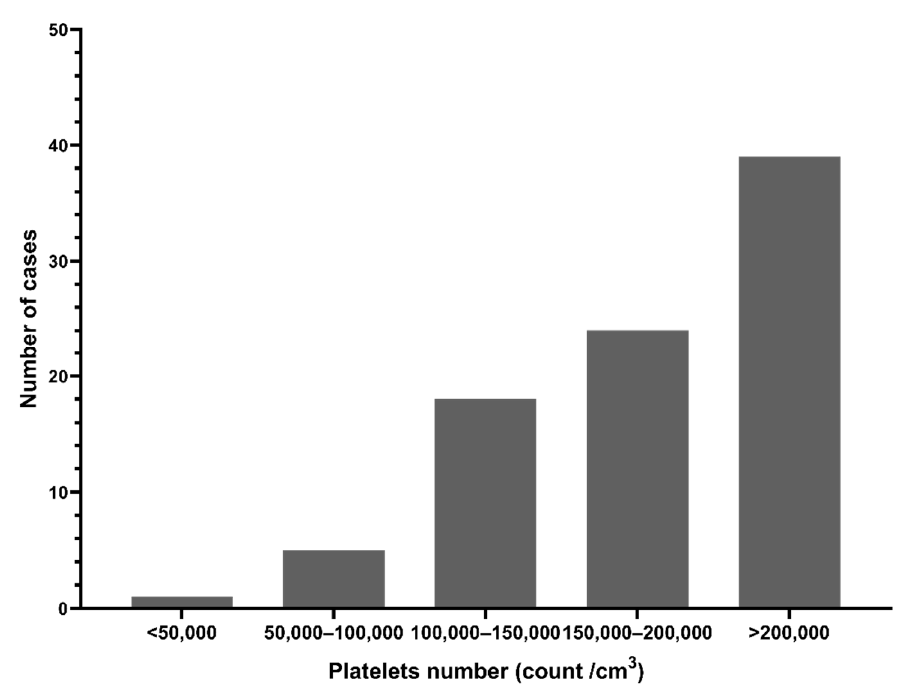
Figure 3. Platelet counts in dengue suspected patients during the 2017 outbreak, Nepal.